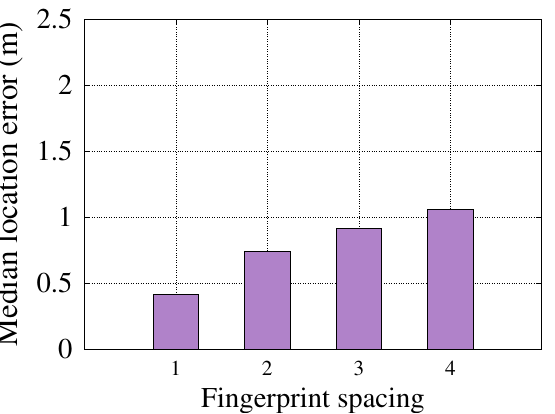
Figure 13. Effect of varying the spacing between reference points on RRLoc